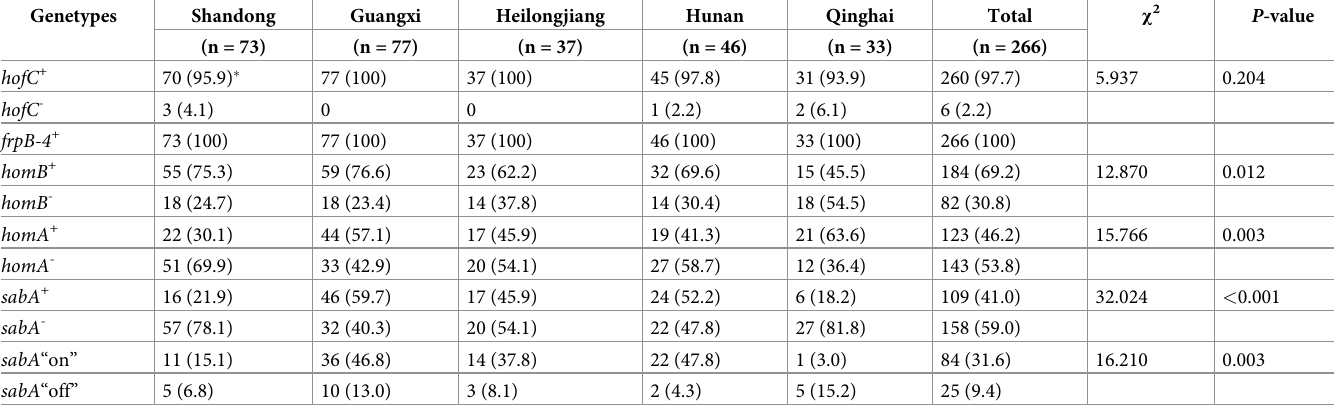
Table 2. Distribution of OMP genes among 267 H . pylori -positive patients with different geographic